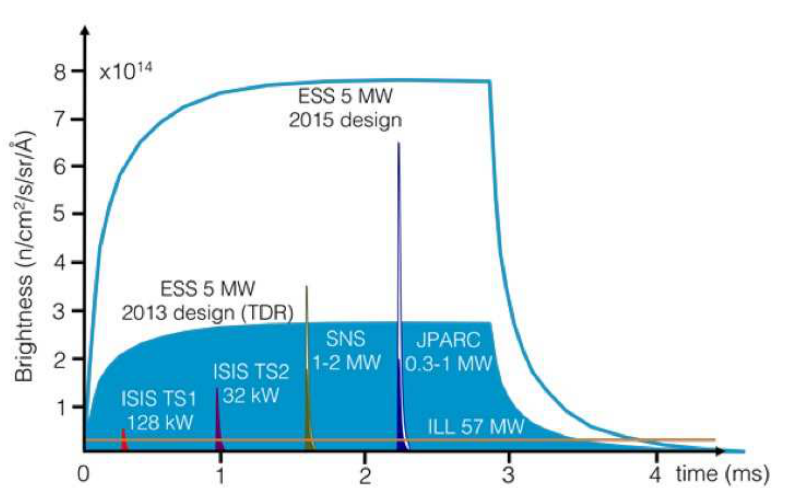
Figure 1 . (Source: ESS) Neutron production from existing and planned spallation sources. The nominal SNS power is 1 MW at proton energy 1 GeV, with a plan to reach 2 MW by 2026. The ESS power will be 5 MW at 2 GeV circa 2023, with the ability to further upgrade. Di(cid:11)erences in the duration of the protons-on-target (POT) pulse are visible in the (cid:12)gure. The ESS will generate an increase in neutron brightness by a factor 30{100 with respect to previous spallation sources, and an order of magnitude larger neutrino yield than the